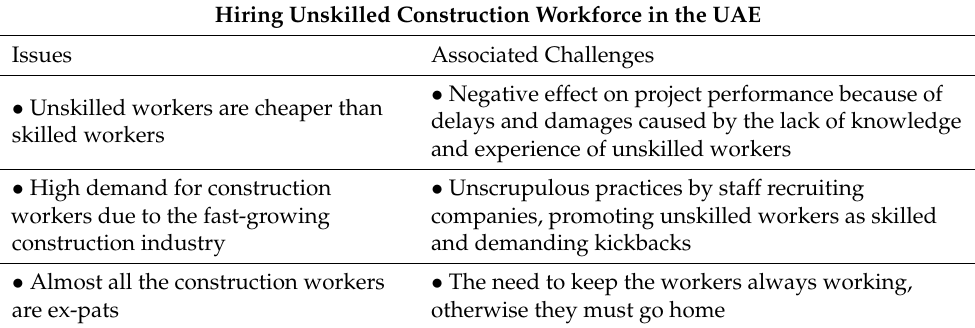
Table 2. Issues and associated challenges in hiring unskilled craft